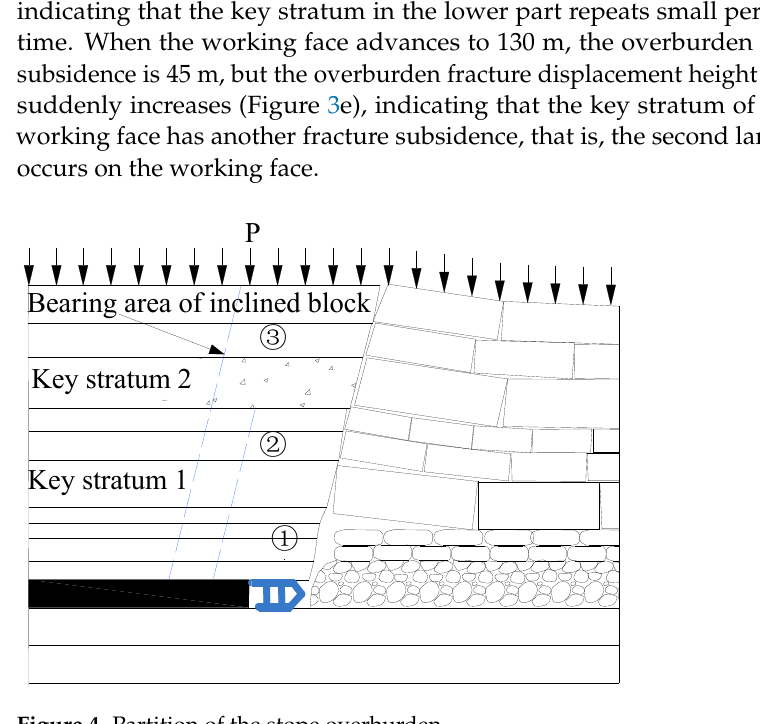
Figure 4. Partition of the stope overburden.